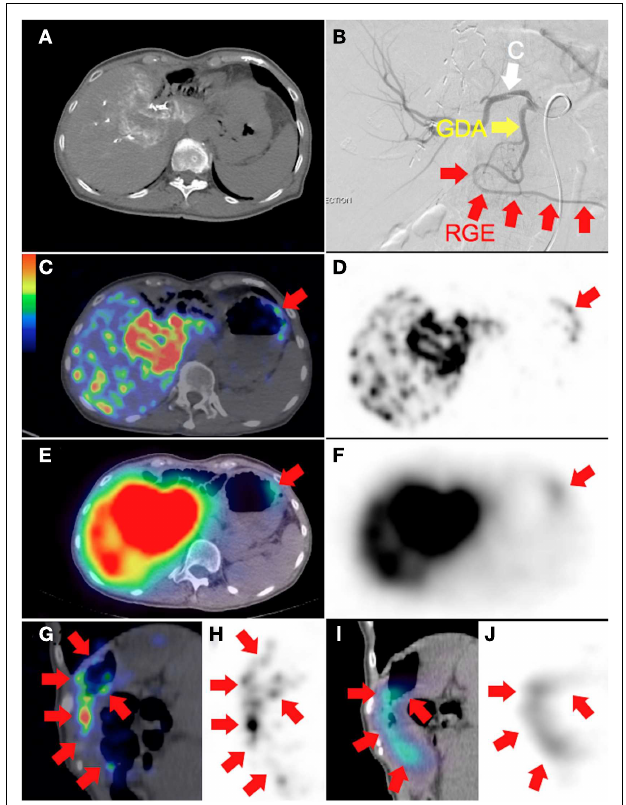
FIGURE 3 | (A) Recurrent cholangiocarcinoma at the surgical margin of a previous left hemi-hepatectomy, seen on catheter-directed CT hepatic angiogram of the right hepatic artery. RE was performed with the catheter tip in the right hepatic artery, beyond the origin of the gastroduodenal artery. Prophylactic coil embolization of the gastroduodenal artery was not performed at the discretion of the interventional radiologist. (B) Post-RE digital subtraction angiogram with the catheter tip (“C”) position unchanged demonstrates significant vascular stasis and reflux of contrast in the common hepatic, gastroduodenal (“GDA”), and right gastroepiploic (“RGE”) arteries. (C,D,G,H) 90 Y PET/CT in trans-axial and saggital planes depict in high resolution, non-target activity in a non-random distribution conforming to the anatomy of the gastric greater curve. (E,F,I,J) 90 Y